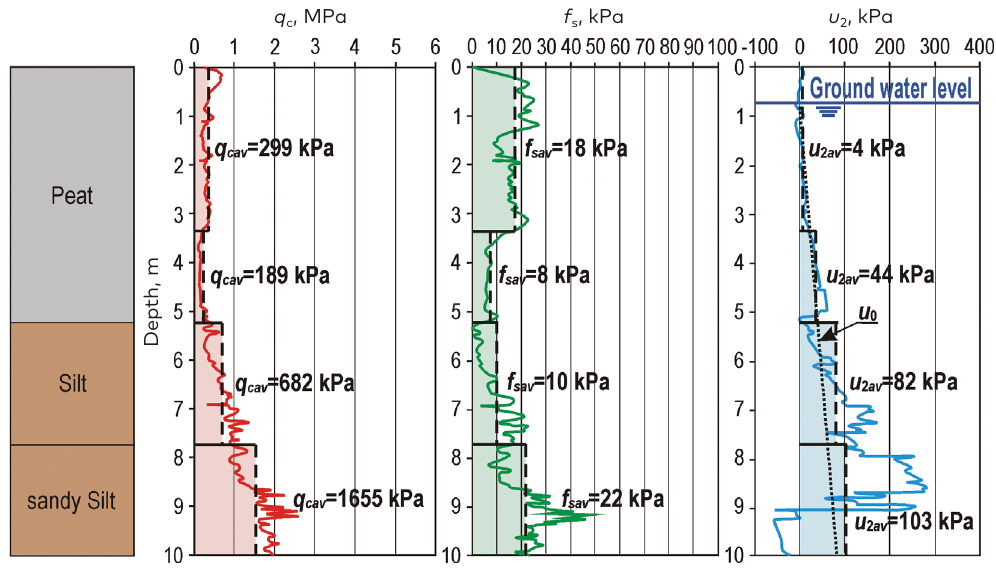
Figure 3. CPTU test results in research point